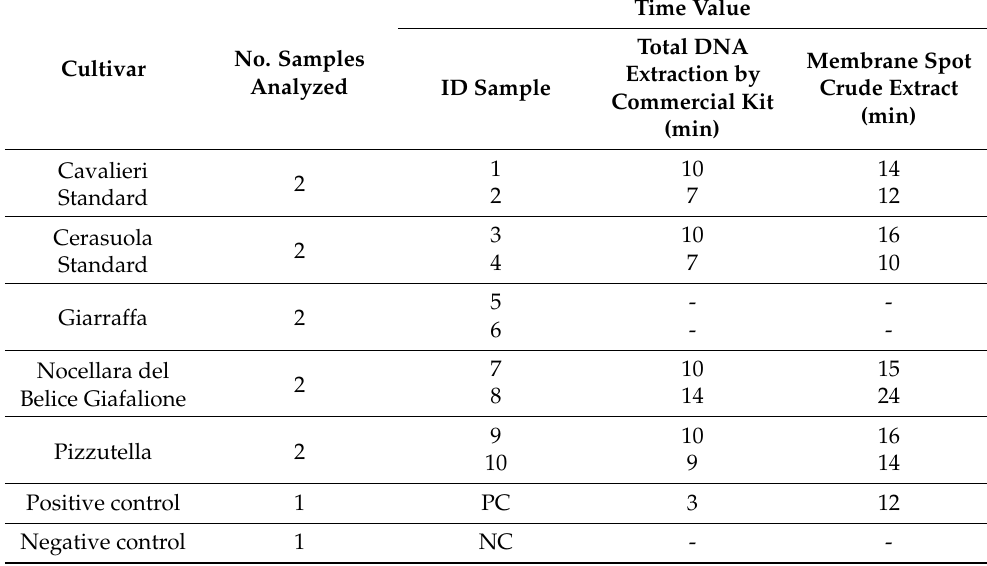
Table 5. Comparison of two different sample preparation methods for the identification of the presence of OEGV in olive